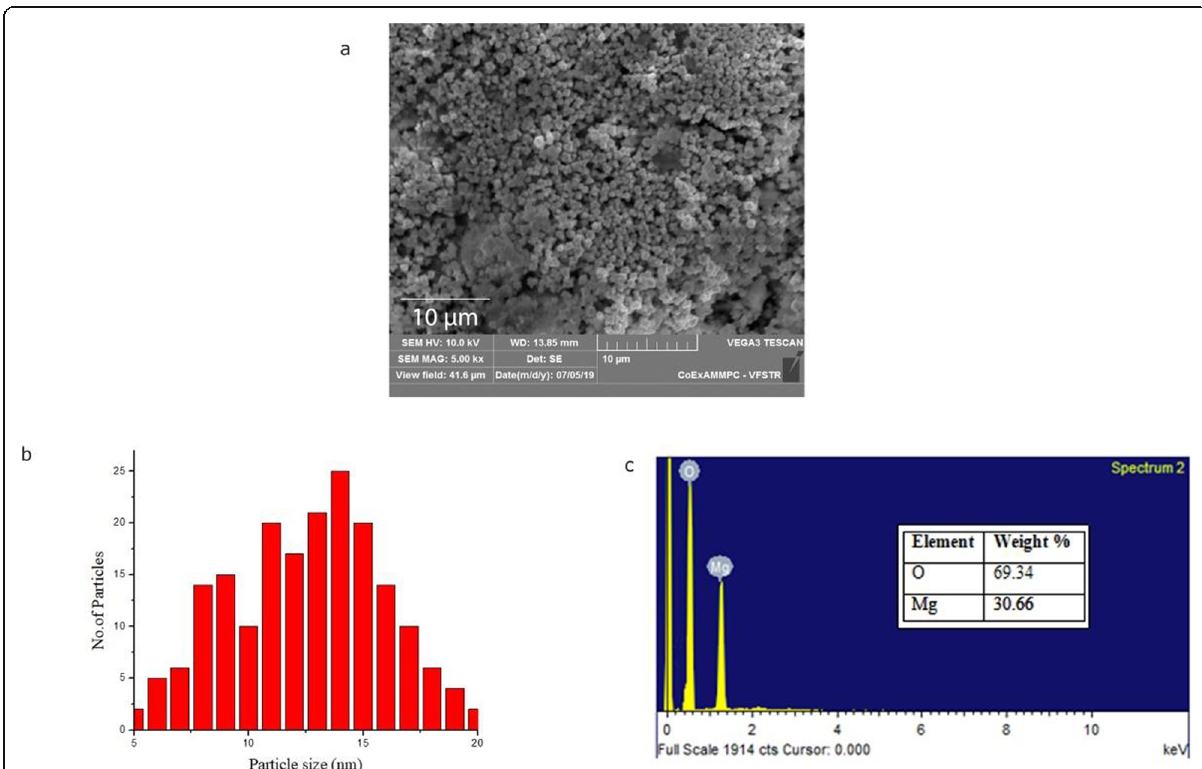
Fig. 5 a SEM images of biosynthesized MgO nanoparticles at scale bar 10 nm. b SEM images of biosynthesized MgO nanoparticles at scale bar 10 nm. c EDS profile of biosynthesized MgO